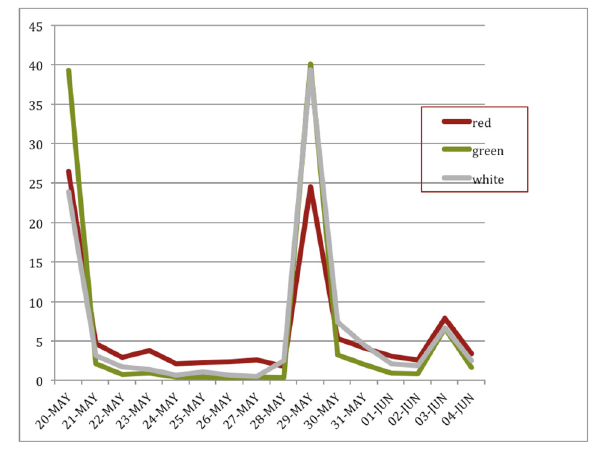
Figure 6. Number of tweets over time - percentage within single zone (whole database, in the 3 zones of Figure